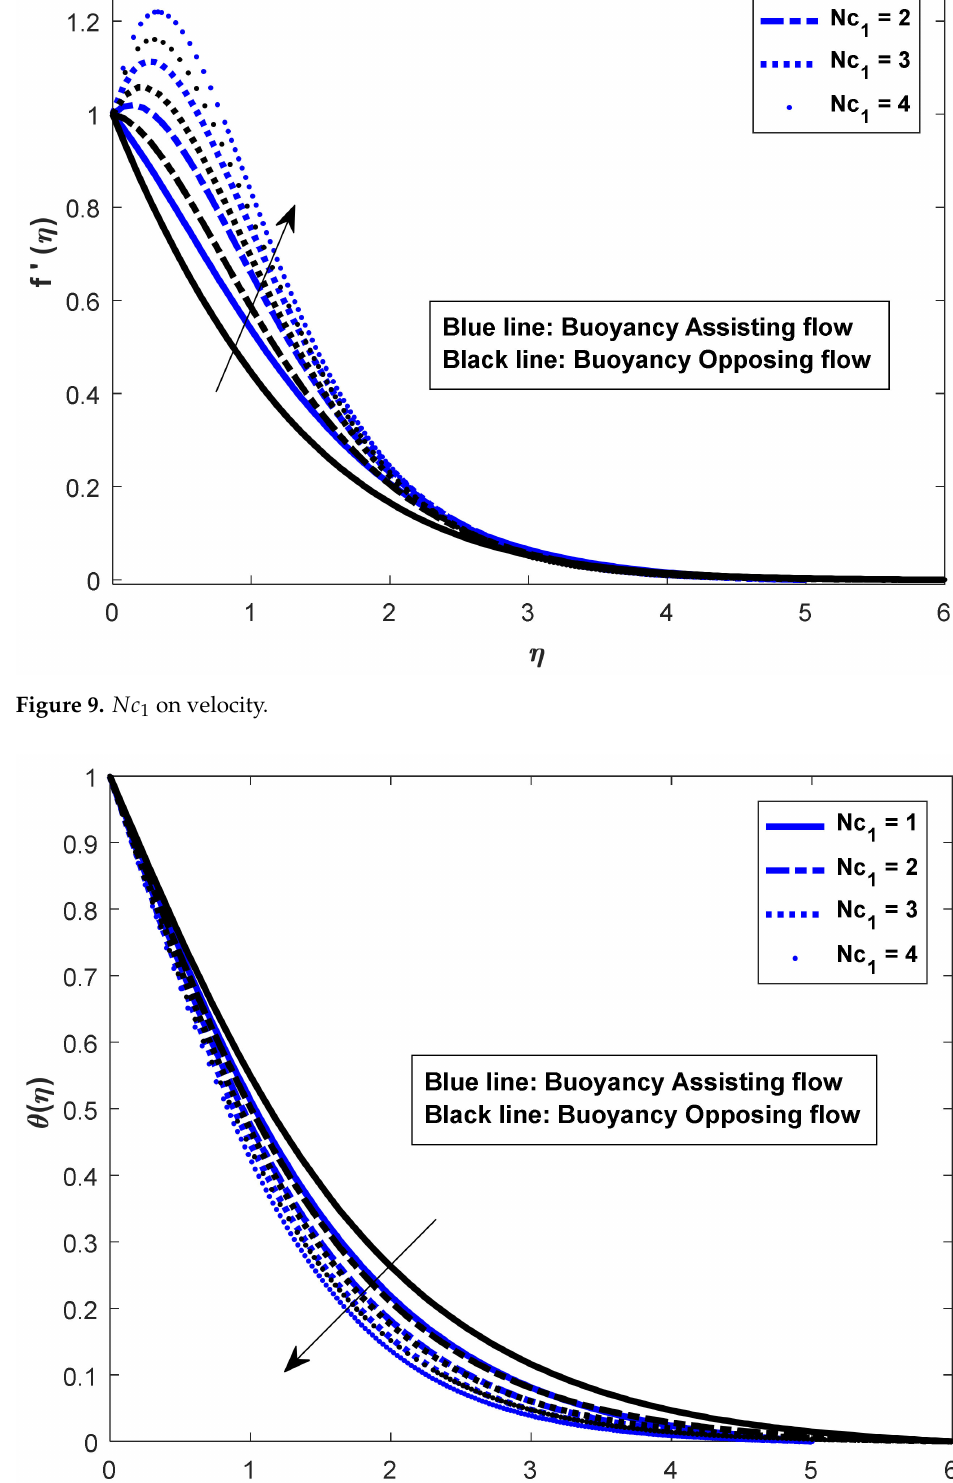
Figure 10. Nc 1 on